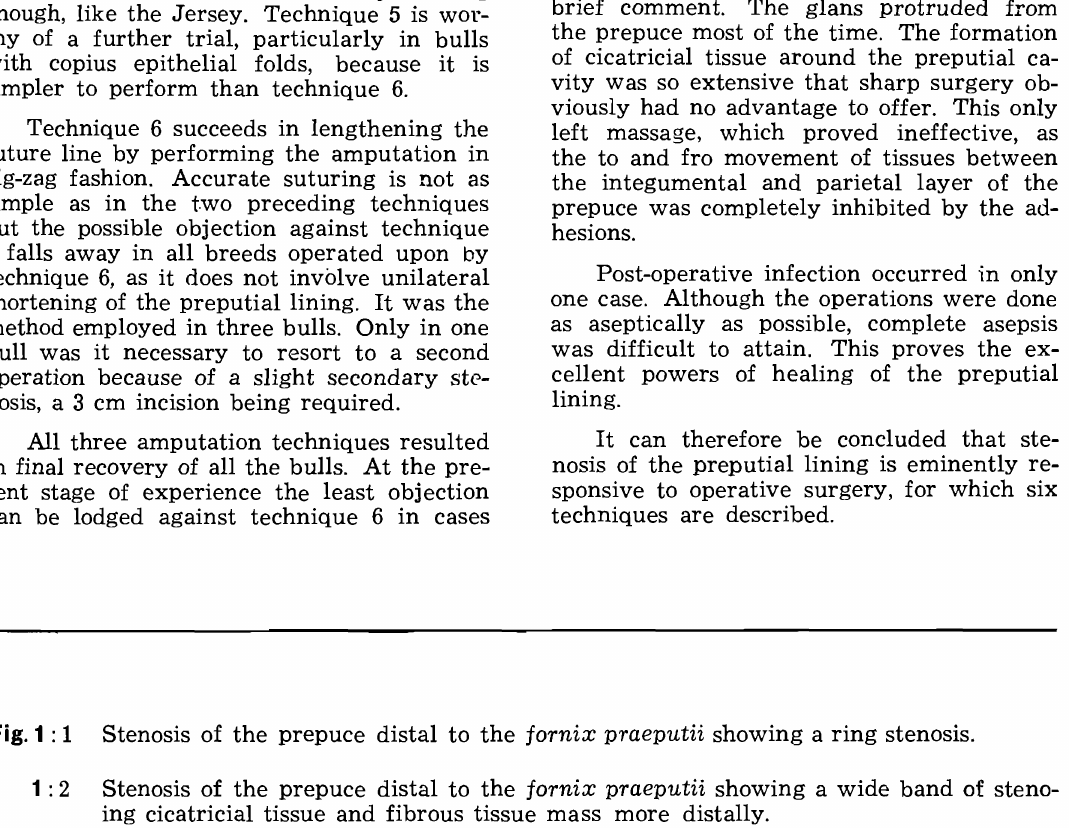
The longitudinal